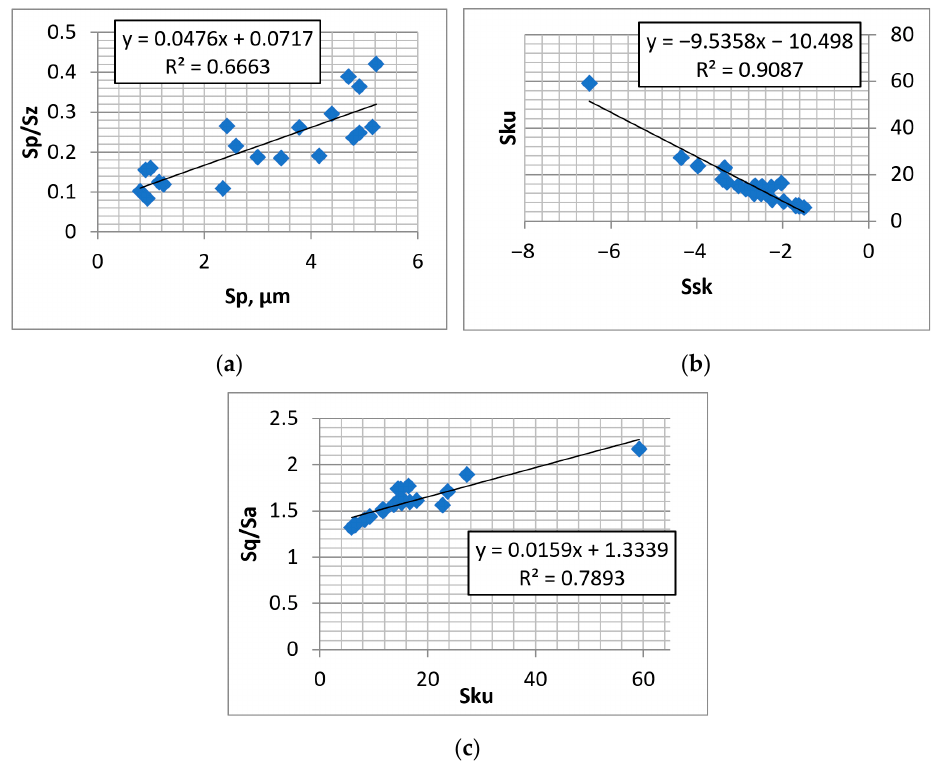
Figure 12. Dependencies between parameters: Sp–Sp/Sz ( a ), Ssk–Sku ( b ), and Sku–Sq/Sa ( c ) of surfaces after abrasive blasting followed by lapping.